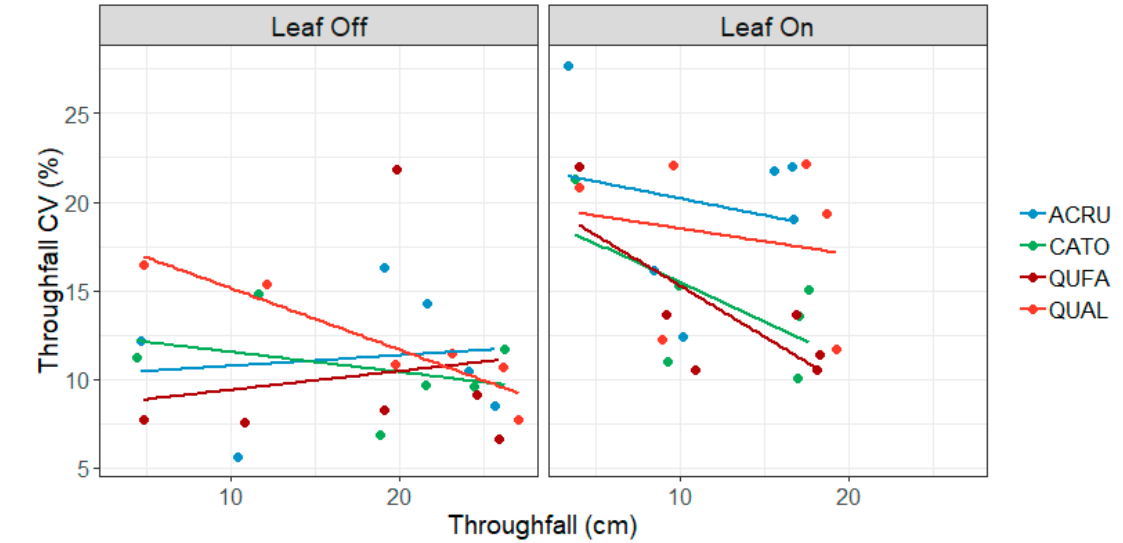
Figure 3. Coefficient of variation (CV) in overstory throughfall by leaf phase and species. Species codes: ACRU = red maple, CATO = mockernut hickory, QUFA = southern red oak, QUAL = white oak.